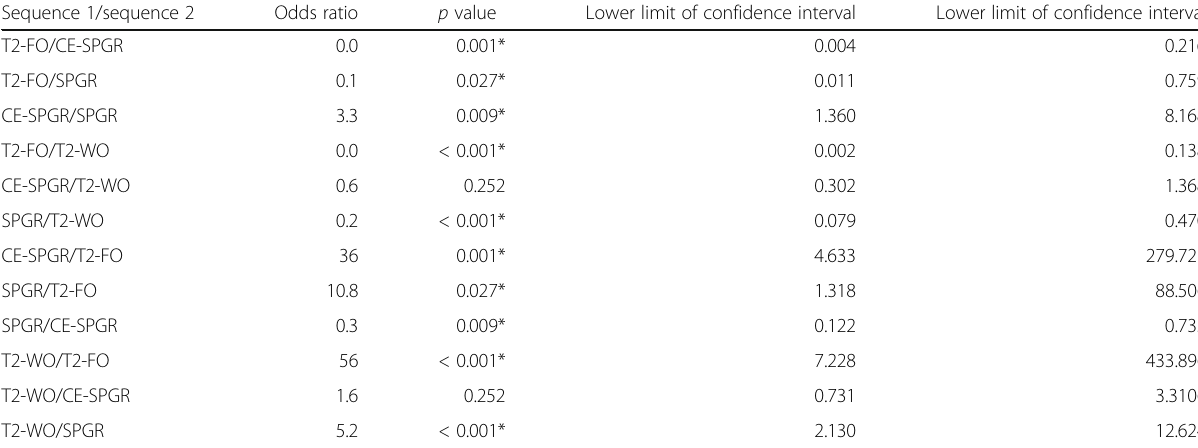
images. *Statistically significant